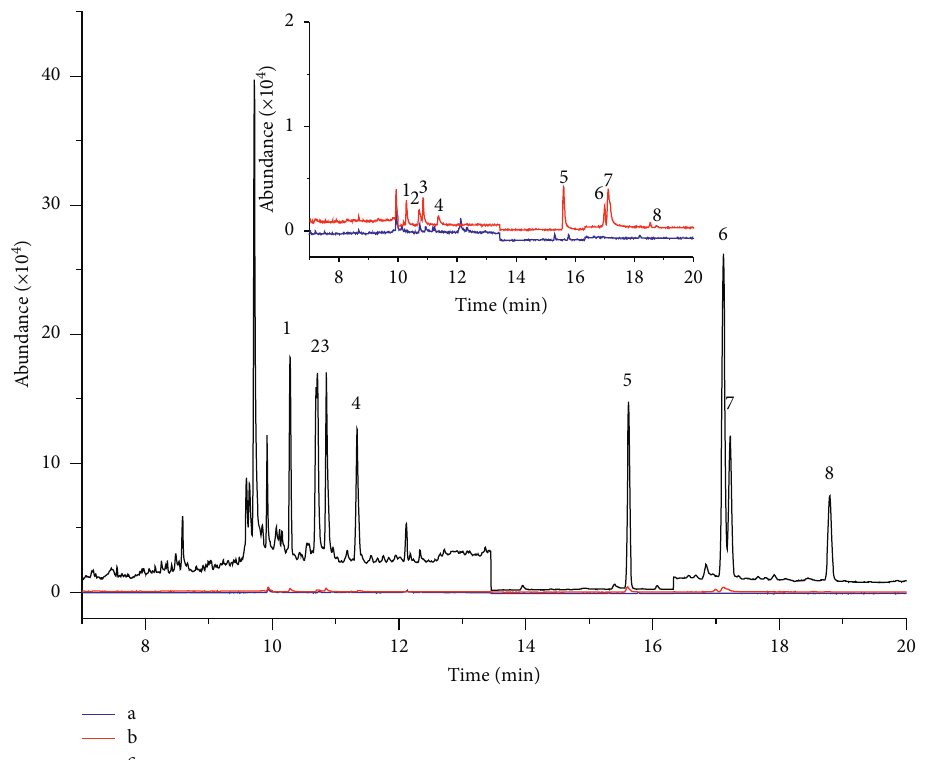
Figure 6: Typical GC-MS chromatograms of (a) blank matrix of spinach sample in SIM mode using the optimized QuEChERS procedure. (b) A standard spiked with 0.025 μ g/mL of 8 OCPs in the blank matrix purification solution after QuEChERS. (c) A standard spiked with 0.025 μ g/mL of 8 OCPs in the blank matrix purification solution after QuEChERS and then DLLME. (1) α -HCH, (2) β -HCH, (3) c -HCH, (4) δ -HCH, (5) p,p ′ -DDE, (6) p,p ′ -DDD, (7) o,p ′ -DDT, and (8) p,p ′ -DDT. Table 3: Recoveries ( n � 5) and RSDs obtained from 8 OCPs spiked in spinach, cabbage, oilseed rape, and lettuce at three levels. Spinach Cabbage Compounds Spiked ( μ g/kg)